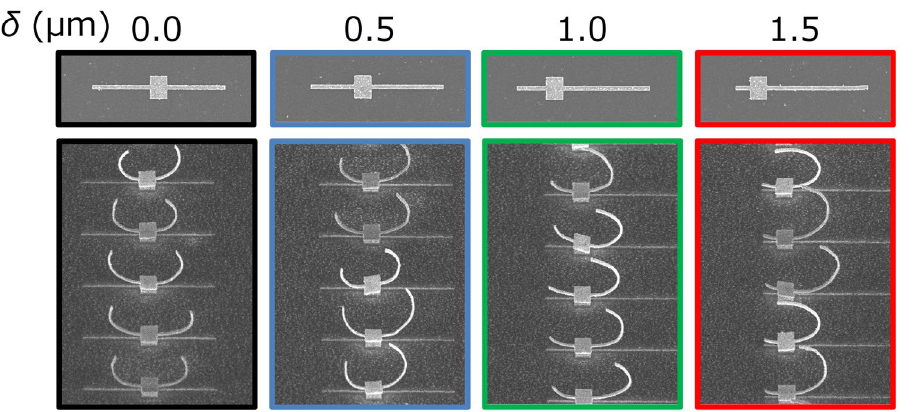
Figure 3. SEM images of 2D gold patterns and 3D-SRRs for respective δ